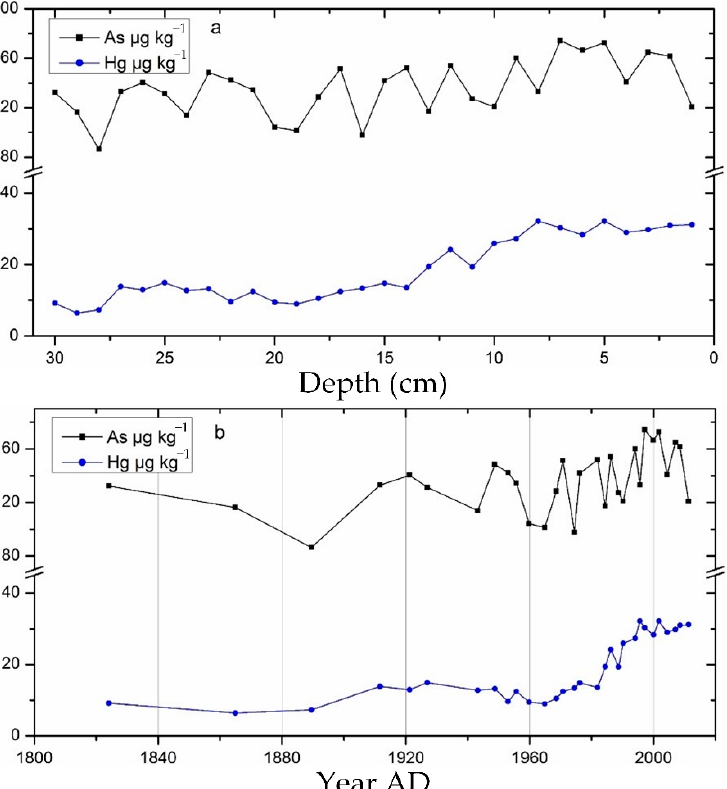
Figure 3. Variations in As (black lines) and Hg (blue lines) concentrations in the peat profile with depth ( a ) and dating ( b ).